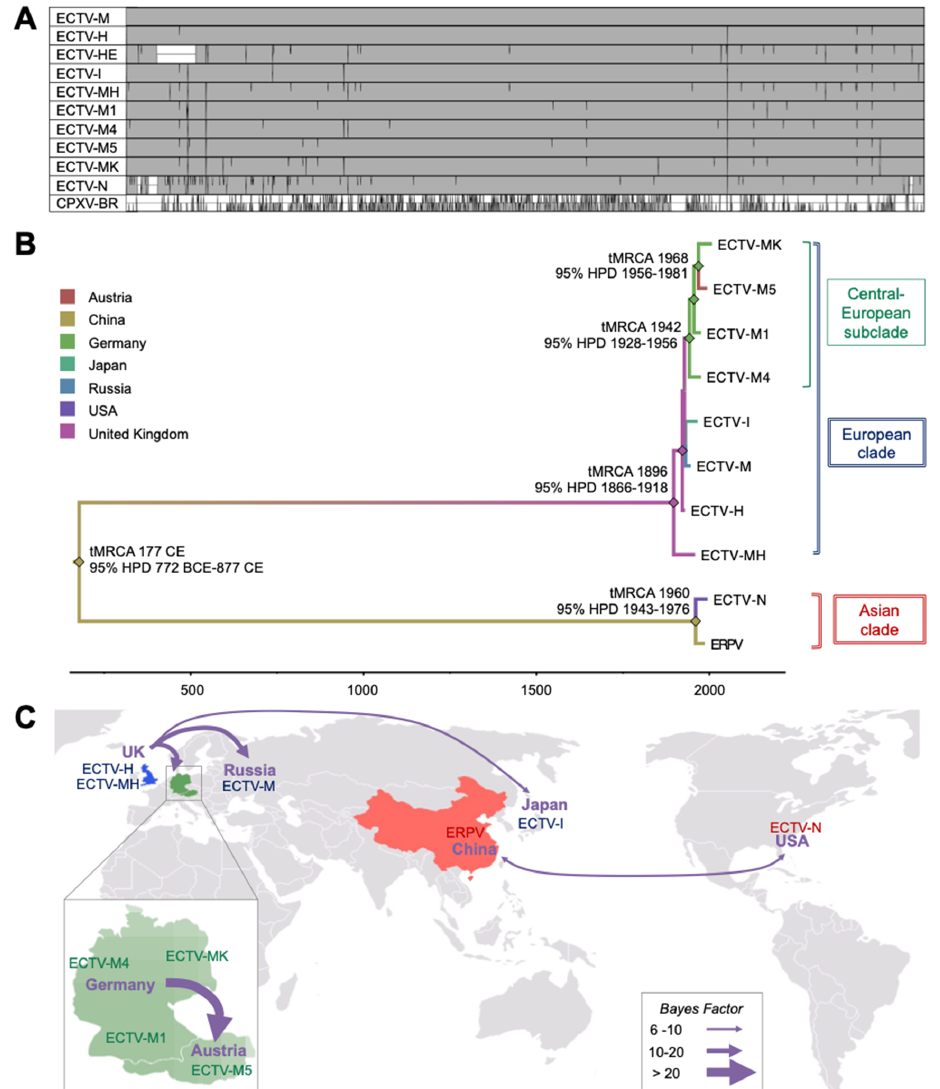
Figure 3. Genomic comparison and phylogenetic analysis of ECTV isolates and strains. ( A ) Genome alignment of ECTVs to the reference genome of ECTV-M, showing 100 bp windows with identities below 99%. Vertical lines indicate single nt changes as compared to ECTV-M. The white box in ECTV-HE indicates the absence of that particular genomic region as compared to the other strains. In this analysis, regions containing direct sets of repeated sequences, as for the DRI and DRII regions (1–1548; 208,224–209,771 in ECTV-M genome) and the DRIII (reduced to an arbitrary number of 15 repeats for all strains), were not used for the comparison. The low genomic similarity between the ECTV-M and CPXV-Brighton Red (CPXV-BR) is shown to emphasize the high genome similarity among the ECTV isolates and strains. ( B ) Maximum clade credibility (MCC) tree of 64 kbp of the central region of the genome of all ECTVs whose genome is shown. Branches are colored based on country of origin, diamonds indicate PP > 0.9 and their color indicates the country of origin for the time most common ancestor (tMRCA). ( C ) The map shows the origin and the spread of ECTV causing outbreaks in laboratory mouse colonies worldwide based on Bayesian phylogeographic analysis. Arrows represent the spread of ECTV among countries and the color is based on BSSVS values for the movement. Enlarged parts of the map show the main ECTV reservoirs in the European continent where ECTV-M1-M4-M5 and MK strains have been